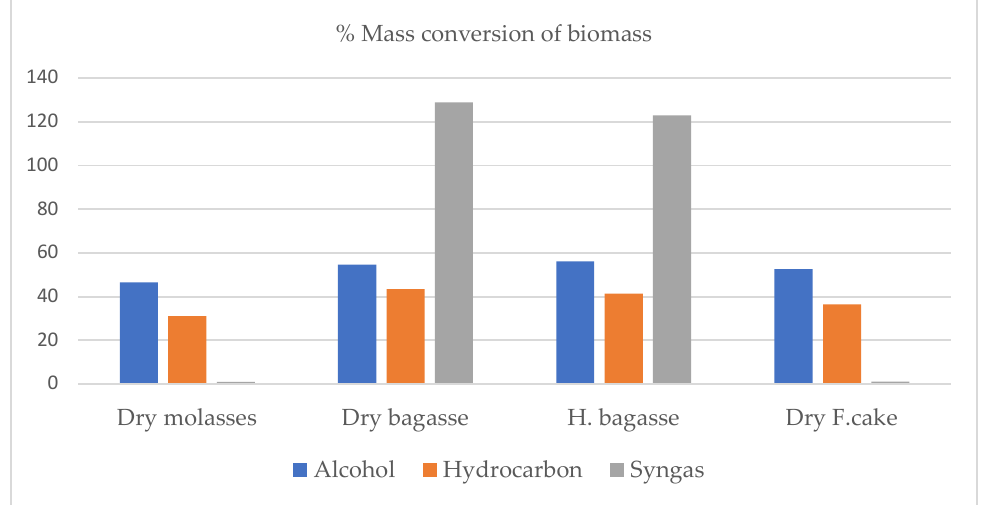
Figure 3. Percent mass conversion of input biomass into desired products.